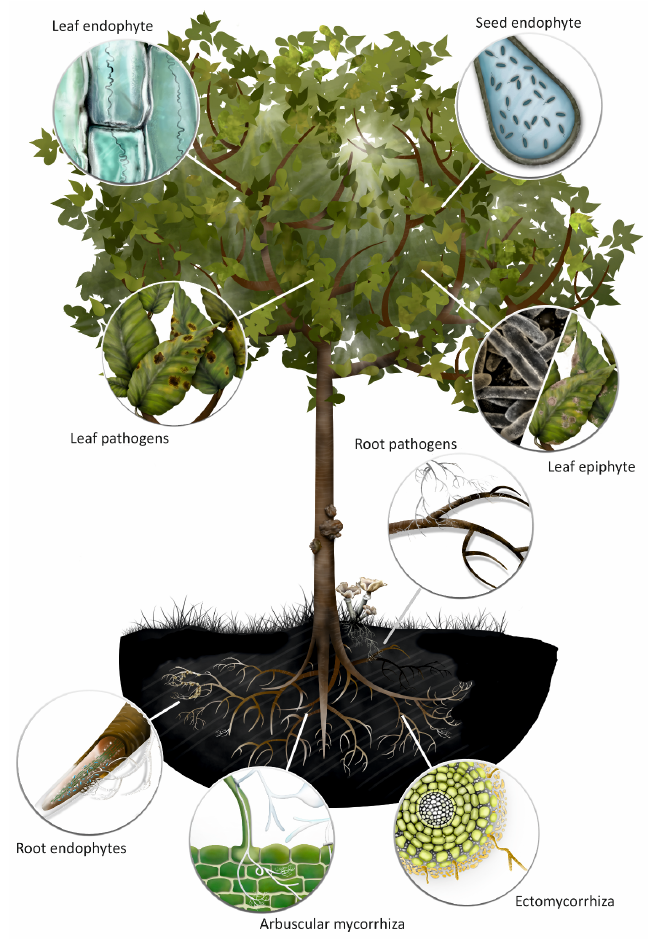
Fig. 1: Plant interactions with mutualistic, pathogenic and neutral fungi in different